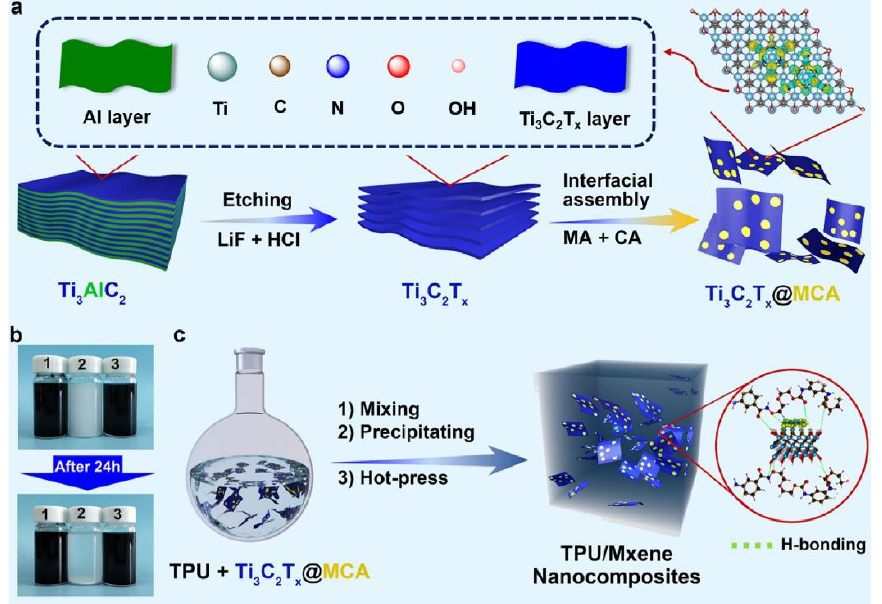
Figure 38. Schematics of the ( a ) synthesis of the Ti 3 C 2 T x @MCA nanohybrid and ( c ) preparation of TPU/Ti 3 C 2 T x @MCA nanocomposites; ( b ) images of (nano)additive dispersions: (1) Ti 3 C 2 T x in water;